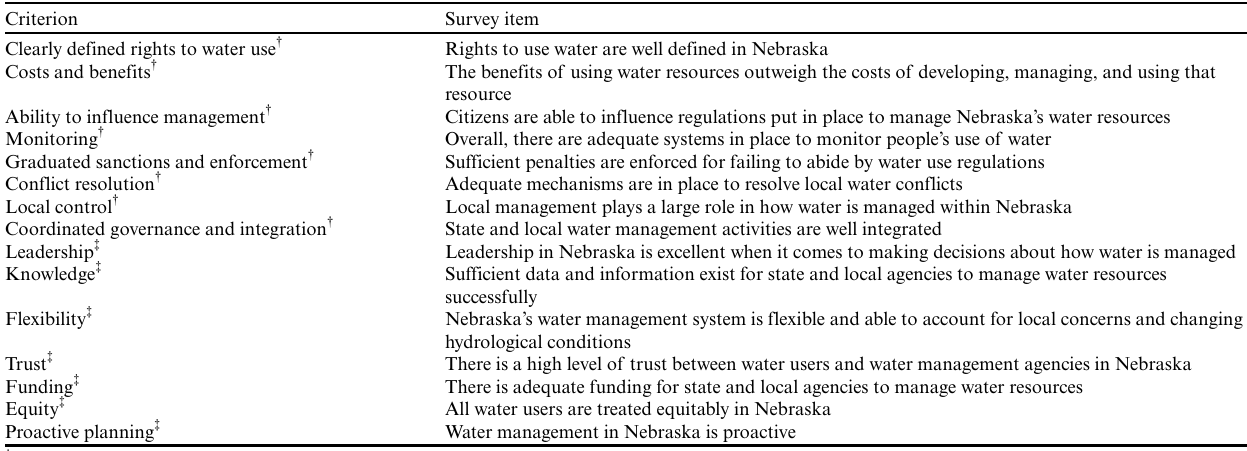
Table 2. Criteria for promoting successful water management. Criteria were judged on a five-point scale, where 1 = strongly disagree, 2 = disagree, 3 = neither agree nor disagree, 4 = agree, and 5 = strongly